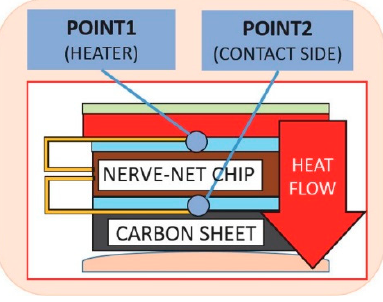
Figure 4. Heat flow measurement points.